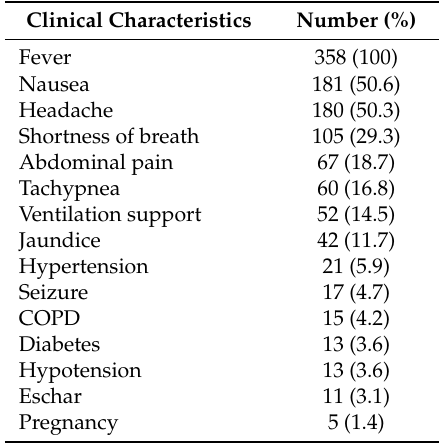
Table 2. Clinical characteristics seen in scrub typhus cases ( n = 358).